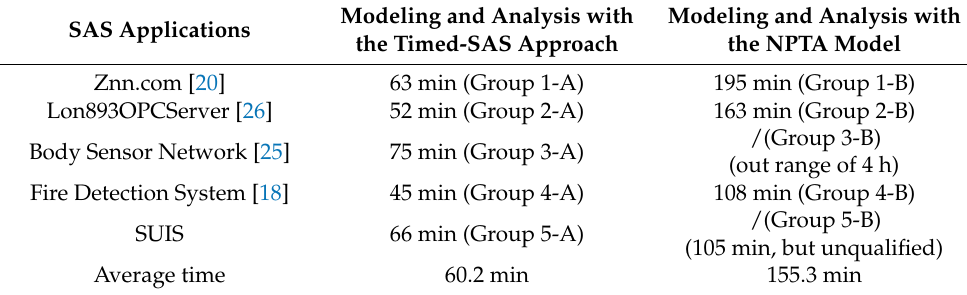
Table 4. The finishing time and work quality for each case study.